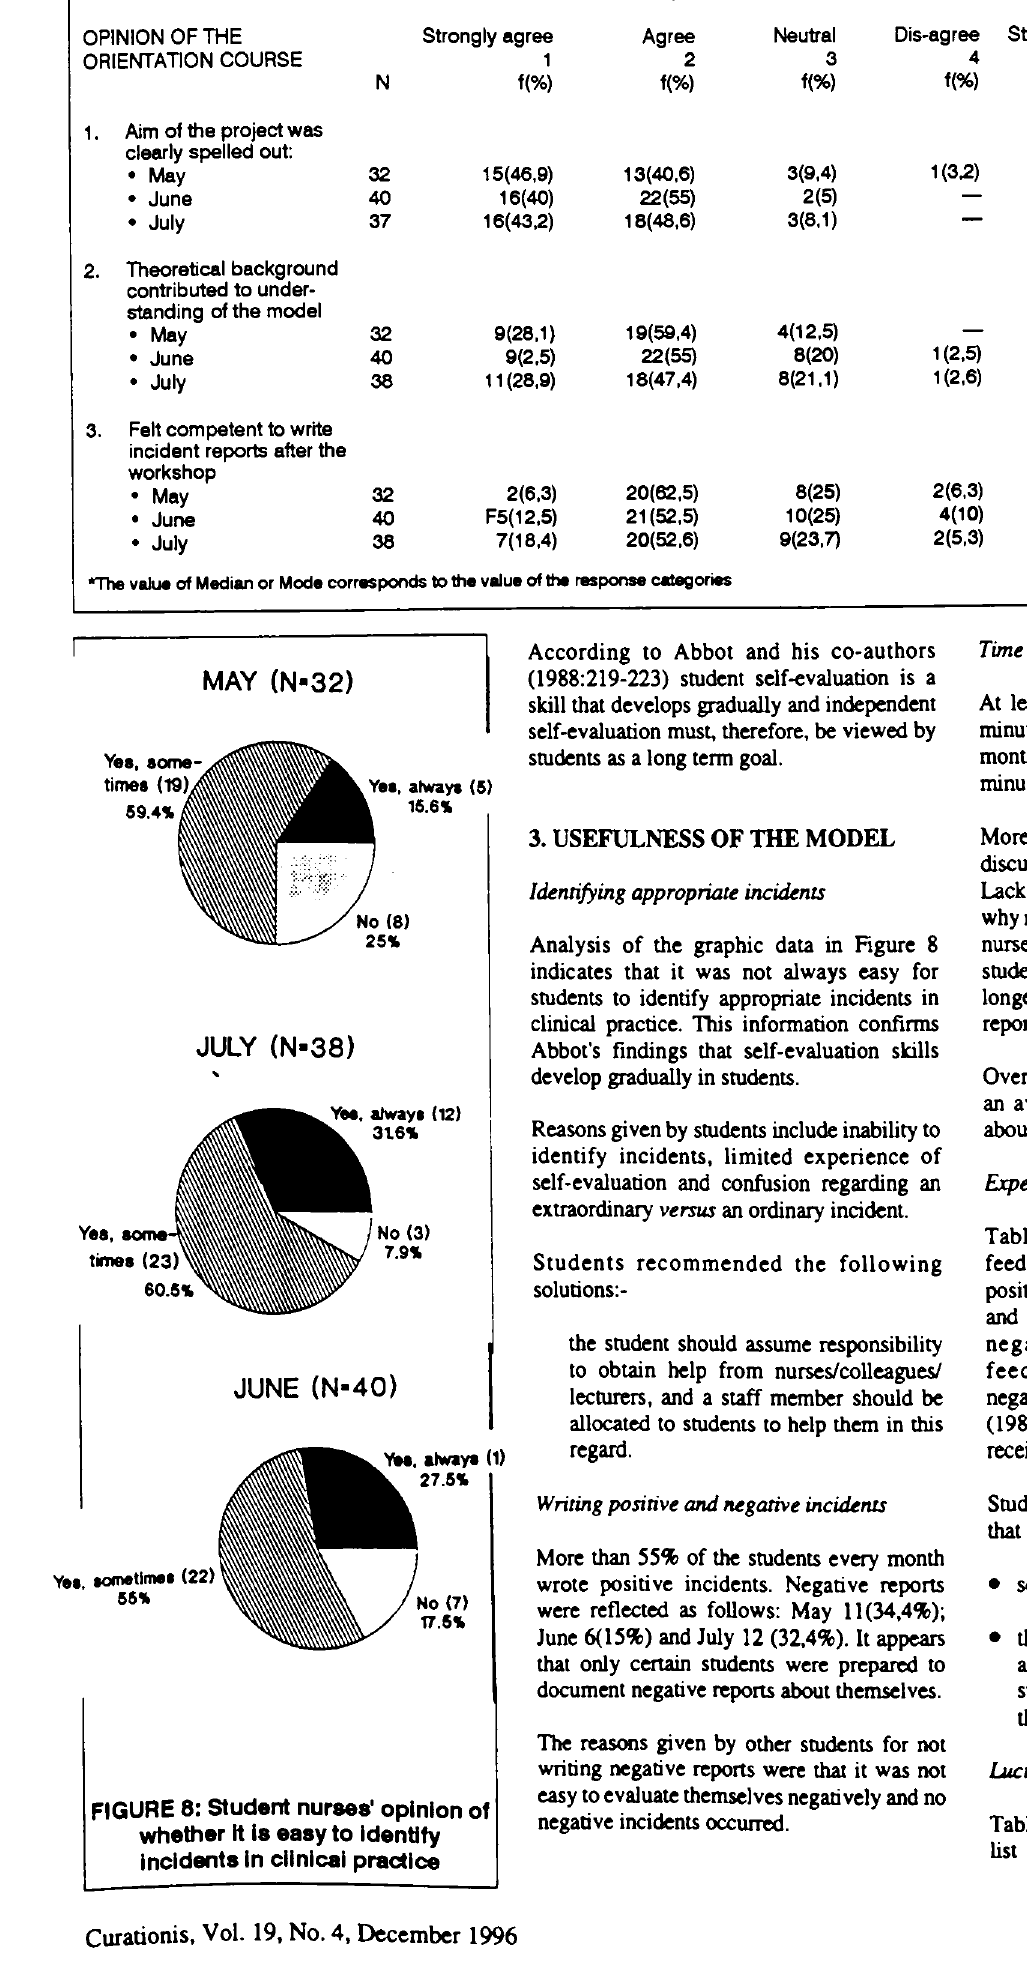
TABLE 6: Students' opinion of the orientation course